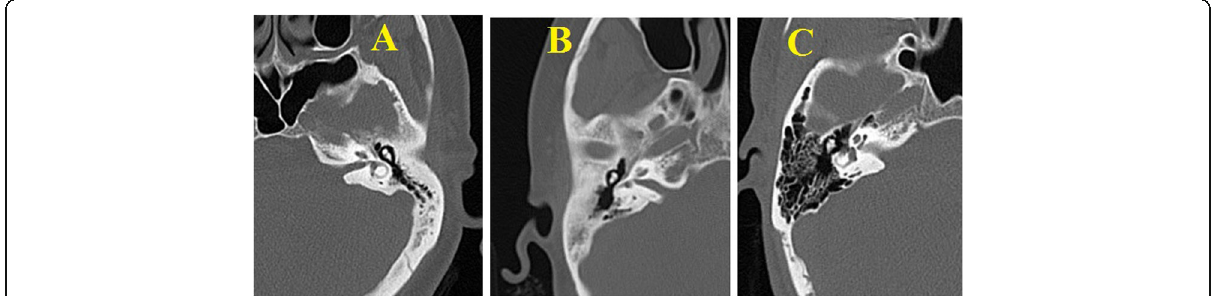
Fig. 3 Grades of the depth of STR. Axial CT images through the STR, showing the three grades of the depth of STR. a Grade 1: shallow STR. b Grade 2: medium-sized STR. c Grade 3: deep